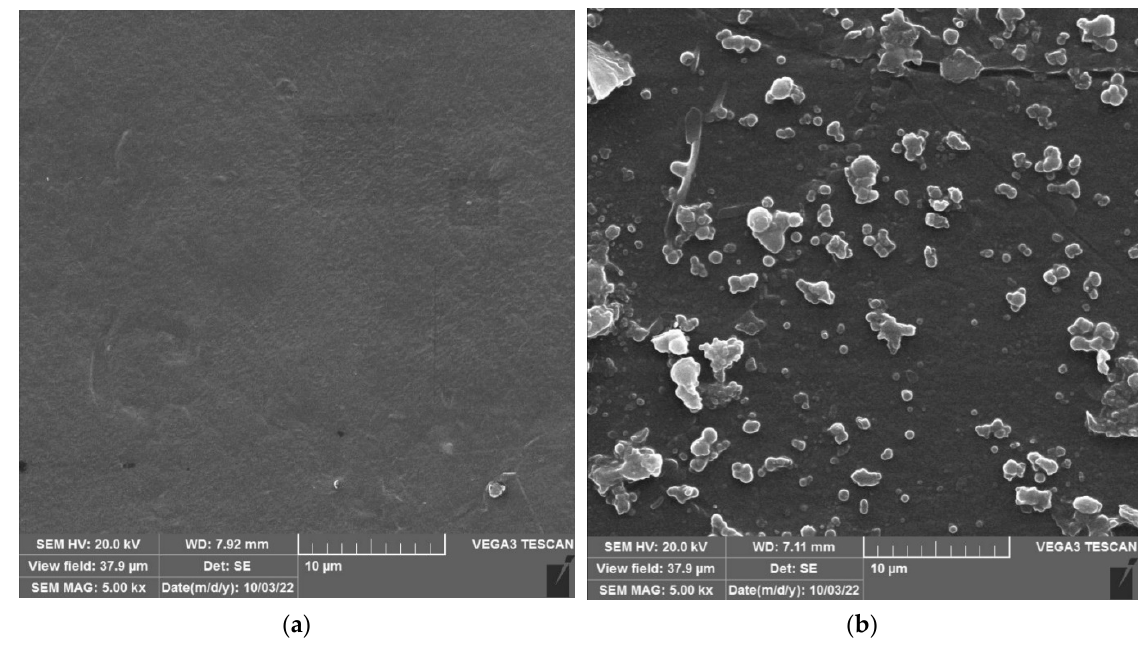
Figure 10. SEM images of ( a ) neat LLDPE, and ( b ) LLDPE impregnated with rosemary essential